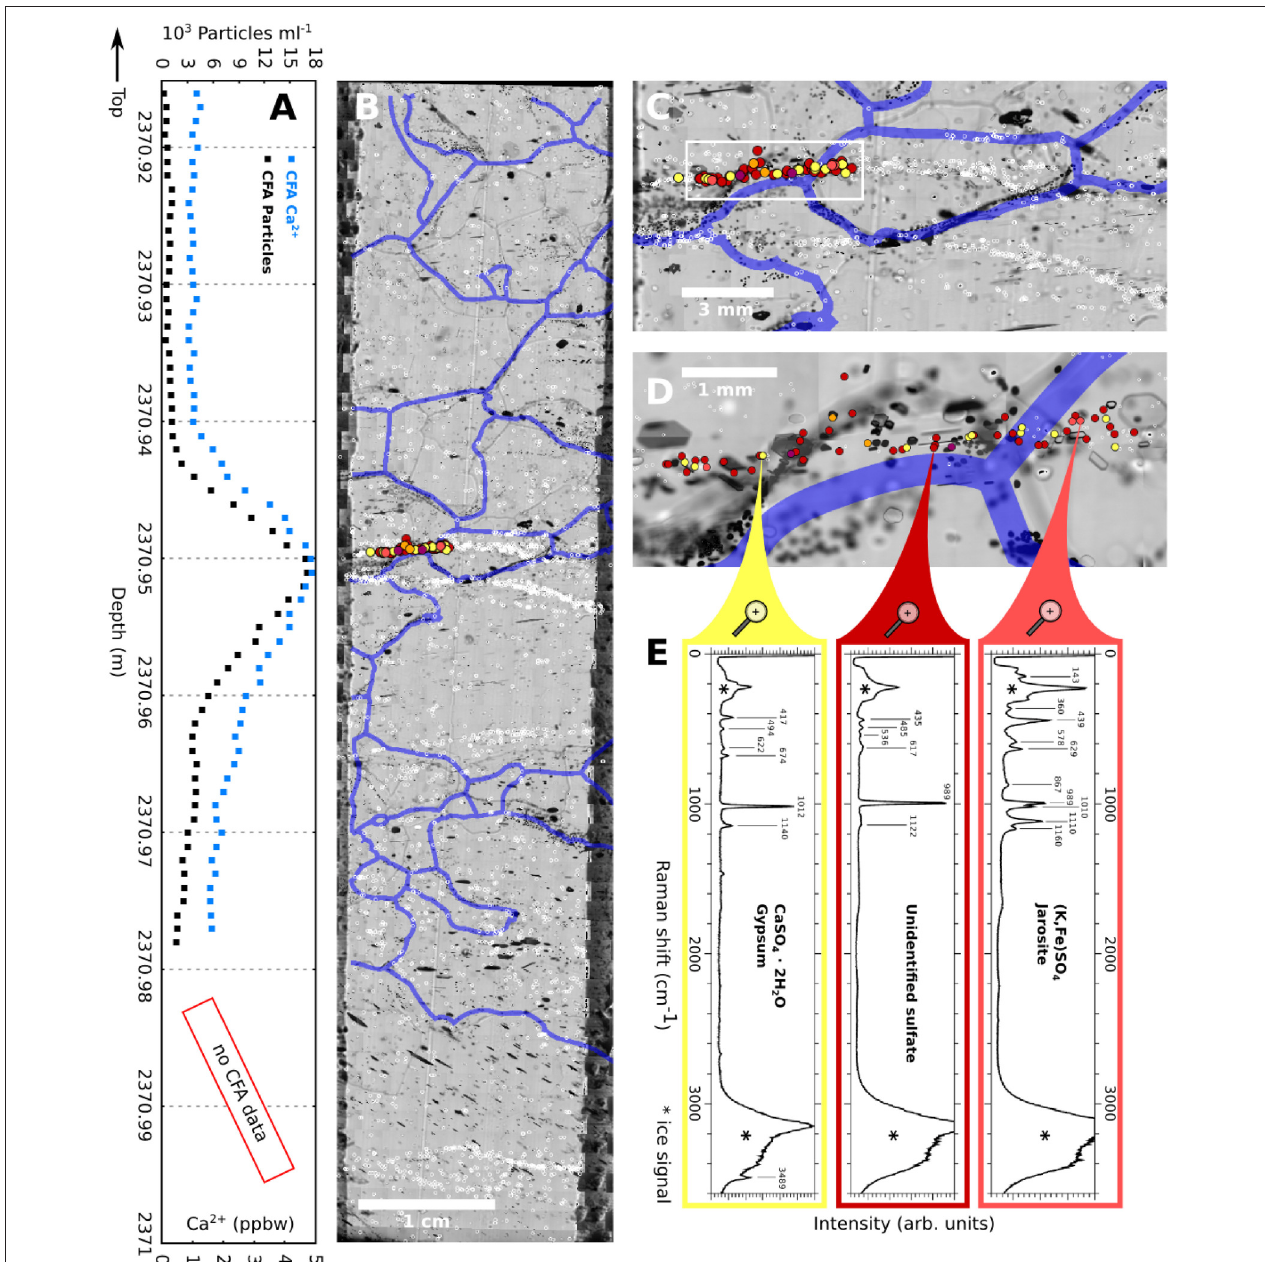
FIGURE 5 | Detail of section 2371-9 (2370.915–2371.0 m): (A) high resolution CFA profile showing Ca 2 + concentration and number of insoluble particles. (B) impurity map, white circles represent positions of individual micro-inclusions presented in Eichler et al. (2017). Colored circles indicate micro-inclusions analyzed with the Raman system. Blue bands indicate positions of grain boundaries at the focus depth of the micro-inclusions. A horizontal double layer of micro-inclusions at 2370.95 m correlates with a strong peak in the CFA profiles. (C) detail of the double layer with area of interest selected for the Raman measurements in the upper horizon. (D) zoom into the upper horizon. (E) raman spectra of three selected micro-inclusions in the upper horizon.